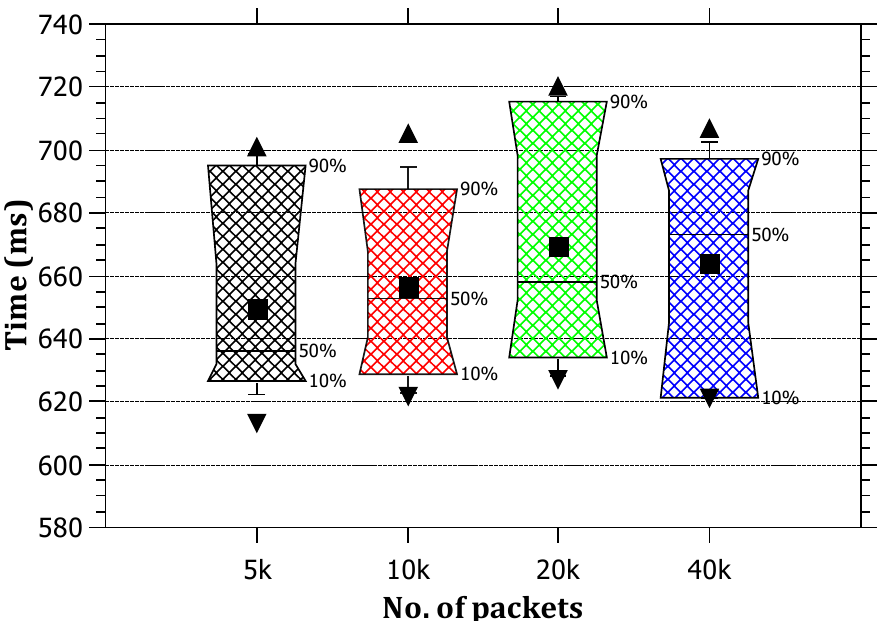
Figure 6. The relationship between the amount of traffic and the tracing